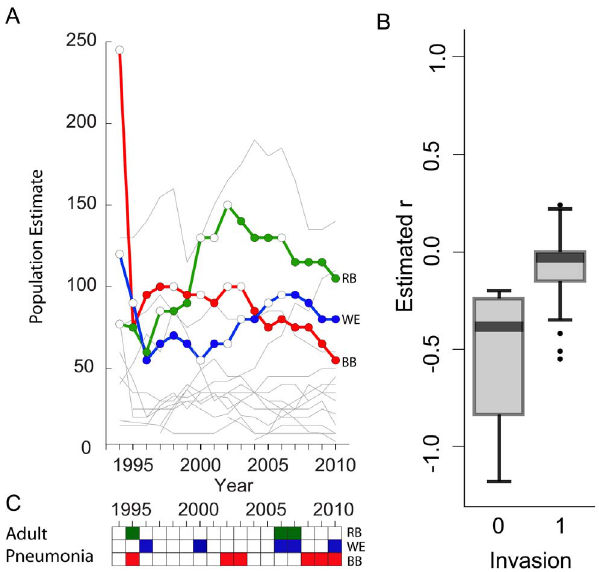
Figure 1. Pneumonia dynamics in Hells Canyon. A. Population estimates and pneumonia dynamics of monitored bighorn sheep populations in Hells Canyon (Idaho, Oregon, and Washington, U.S.A), 1994–2010. Colored lines represent the three most intensively monitored populations: Redbird (RB), Wenaha (WE), and Black Butte (BB). Opaque circles represent years with lamb pneumonia outbreaks (detected or suspected; see Cassirer et al. [20]), open circles represent years when no lamb pneumonia outbreak was detected or suspected. Grey lines represent population size estimates for all other populations monitored in Hells Canyon. The population estimates for Black Butte include the removal of 72 bighorn sheep during the 1995 epidemic [52]. B. Estimated population growth rate, r (natural log of population size in year t divided by population size in year t-1) during the year in which pneumonia invaded the population (invasion=0) and in post invasion years with pneumonia mortalities in adults or lambs (invasion=1). The invasion year r for Black Butte incorporates the removal of 72 bighorn sheep [52]. C. Years in which adult pneumonia mortality was detected in the three populations depicted in A: Redbird (RB), Wenaha (WE), and Black Butte (BB).